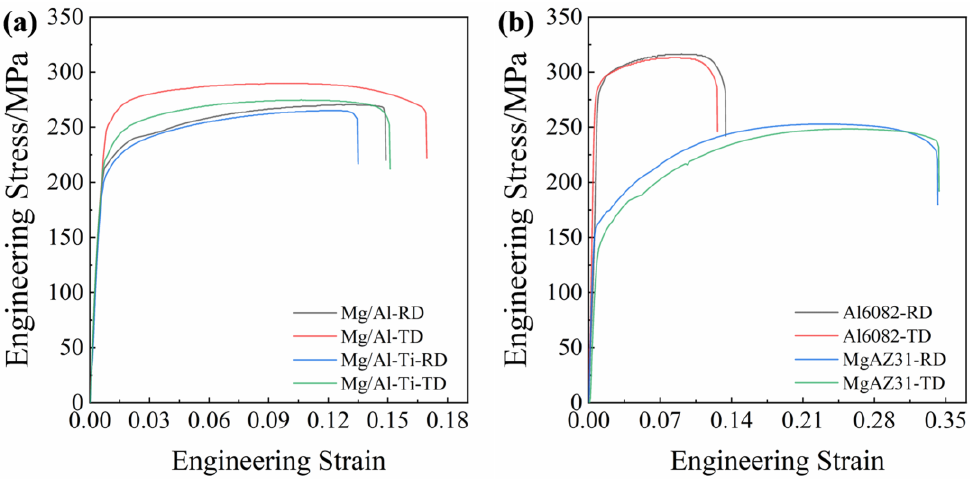
Figure 7. Inverse pole figure and pole figure of the Mg layers in composite sheets after annealing: Mg/Al sheet after annealing at ( a ) 400 °C for 3 h, and ( b ) 400 °C for 10 h, Mg/Al - Ti sheet after an- nealing at ( c ) 400 °C for 3 h, and ( d ) 400 °C for 10 h. RD, TD, and ND refer to the rolling direction, transverse direction, and normal direction, respectively.